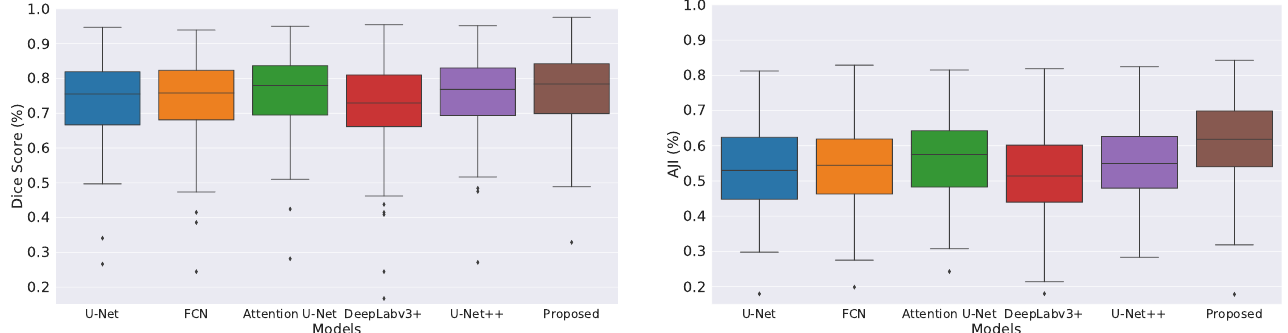
Figure 3. Boxplots of Dice and AJI scores on test dataset. Multiple color boxes highlight the score range of different segmentation methods; the black line inside each box shows the median value, box limits incorporate interquartile ranges Q2 and Q3 (from 25% to 75% of samples), upper and lower whiskers are measured as 1.5 × the distance of upper and lower limits of the box, and all values outside the whiskers are assumed outliers.